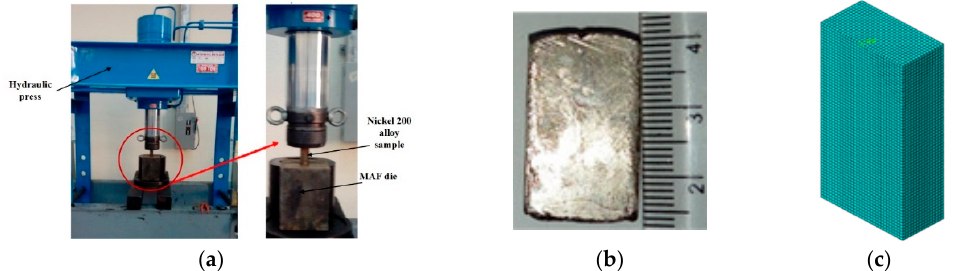
Figure 2. Comparison of experimental and simulative MAF process of Ni 200 alloy. ( a ) Experimental set up, ( b ) actual sample, and ( c ) simulative sample through finite element (FE).